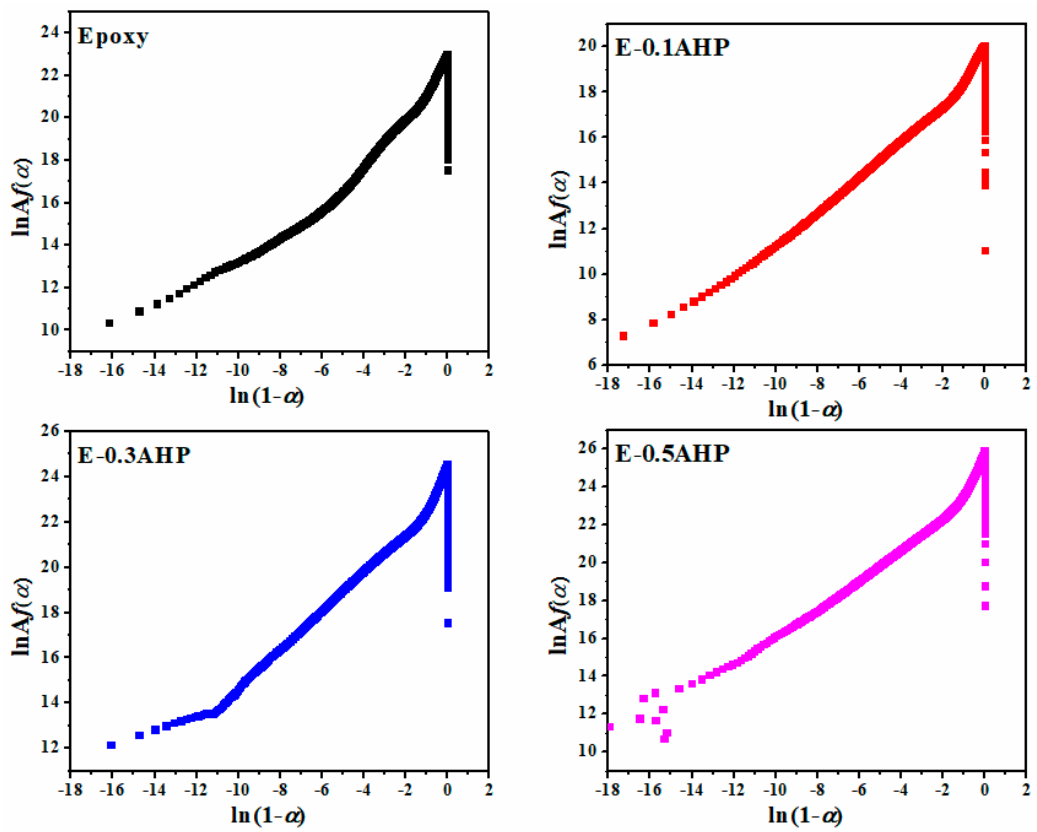
Figure A3. Plots of ln [ Af ( α )] vs. ln (1 − α )for the samples at heating rate of 5 °C/min used in calculation of activation energy via Friedman method.